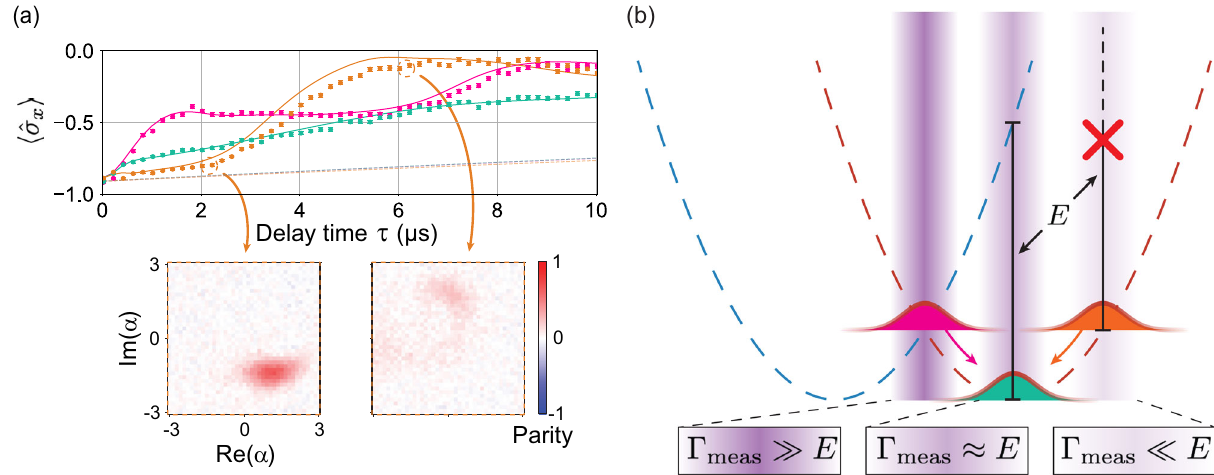
FIG. 4. Branching through a conical intersection. (a) Top: measured expectation value of ˆ σ with standard error bars over time for the x ≈ fj 0 i ≈ 1 . 26 . The g = Δ three different initial states j − i ⊗ j α 0 i , where α ð magenta Þ ; j α g i ð blue green Þ ; j 2 α g i ð orange Þg ⊗ j 0 i g ¼ x a a a a a b magenta wave packet prepared at the CI immediately dephases, whereas the other two dephase more slowly, as they are farther away. , the orange wave packet arrives at the CI and dephases. Solid lines are predictions from a After half of an oscillation period τ ∼ 1 = ð 2 Δ a Þ master equation simulation using independently fitted parameters. Dashed lines represent the negligible background decoherence due to T x 2 ρ on the timescale of the interaction and dissipation. Bottom: unconditional Wigner tomography on the tuning mode at τ ¼ 2 μ s (left) ≈ j 2 α and 6 μ s (right) for preparing j α 0 i , revealing a coherent wave packet before and dephased state after passage through the CI. g i a a The distortion of the Wigner function from a Gaussian at τ ¼ 2 μ s suggests the presence of a residual self-Kerr nonlinearity in the oscillator. (b) A semiclassical interpretation of the dephasing versus location of the three initial wave packets prepared in (a). The ˆ H potential surfaces are shown in dashed lines to emphasize that they are no longer exact in the diagonalized basis of . The dissipative LVC dynamics arises from a competition between the ˆ σ energy gap E with the finite strength of the dephasing Γ x meas